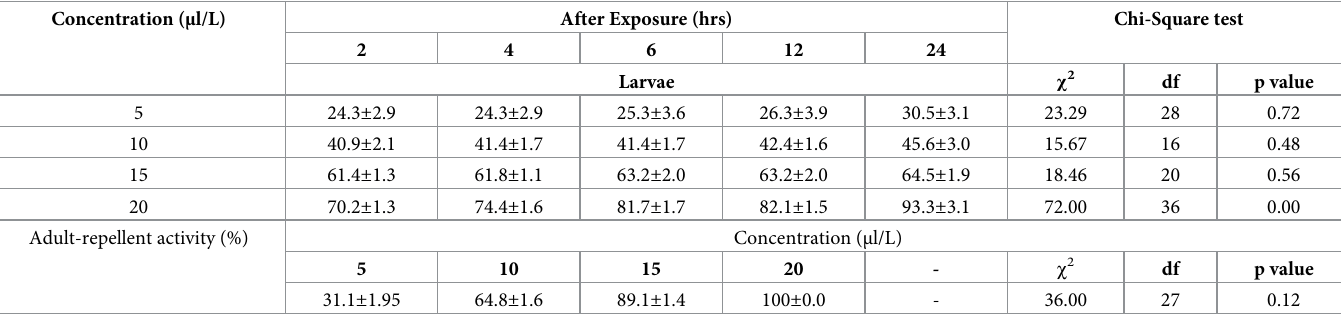
Table 5. Repellent activity (%) of essential oil from C . citrinus against T . Castaneum . Concentration ( μ